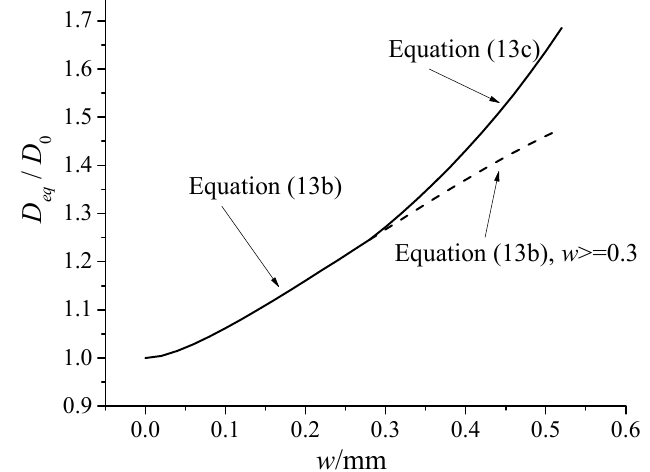
Figure 10. The variation of D eq / D 0 versus the crack width w obtained from Equation (13).